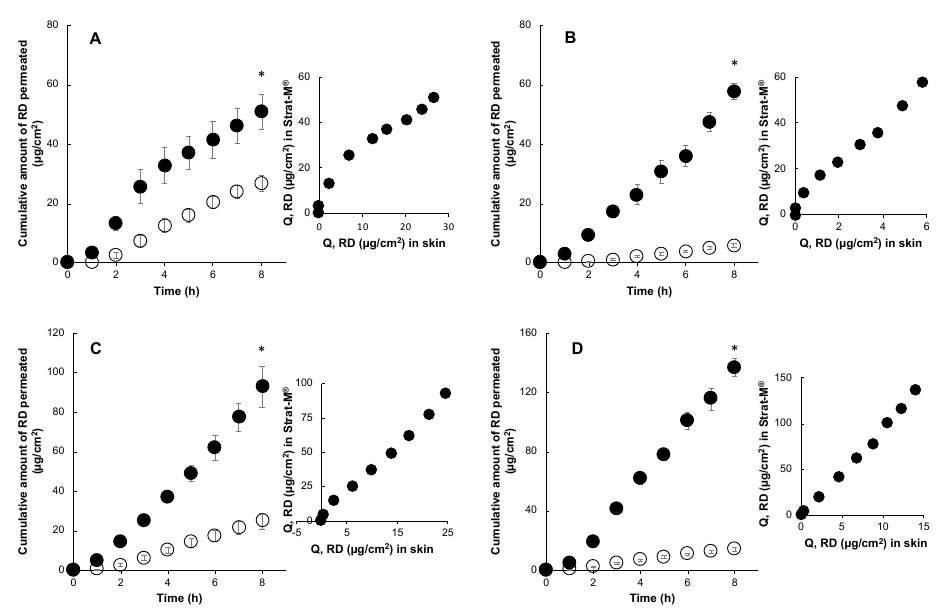
Figure 1. Time course of the cumulative amount of rhododendrol (RD) that permeated through Strat-M ® ( ● ) and porcine skin ( ○ ) and their correlation under in-use (finite dose) conditions. 1% RD in water single application 10 µL/cm 2 ( A ), single application 10 µL/cm 2 lotion ( B ), single application 20 µL/cm 2 lotion ( C ), layered application 10 and 10 µL/cm 2 lotion ( D ). Each point represents the mean ± S.E. ( n = 4). Significant difference (* p < 0.05) between RD permeation from single application (10 µL/cm 2 ), layered application, single application (20 µL/cm 2 ) of lotion, and single application (10 µL/cm 2 ) aqueous solution through Strat-M ® and porcine skin.